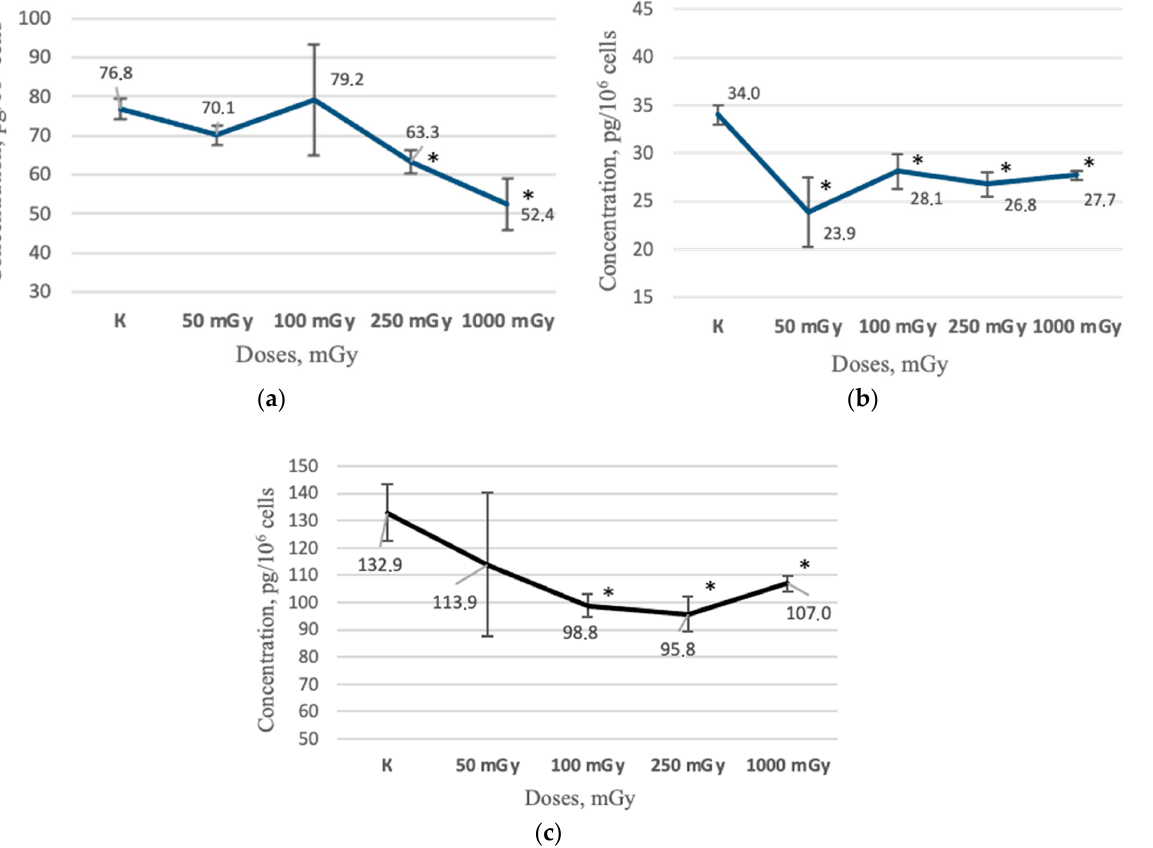
Figure 6. The results of ELISA test of conditioned mediums non-irradiated and irradiated MSCs groups (n = 6): ( a ) the IL-6 concentration in MSCs conditioned medium 43 days after irradiation; ( b ) the IL-6 concentration in MSCs conditioned medium 64 days after irradiation; ( c ) the IL-8 concen- tration in MSCs conditioned medium through 64 days after irradiation. * ( p < 0.05).